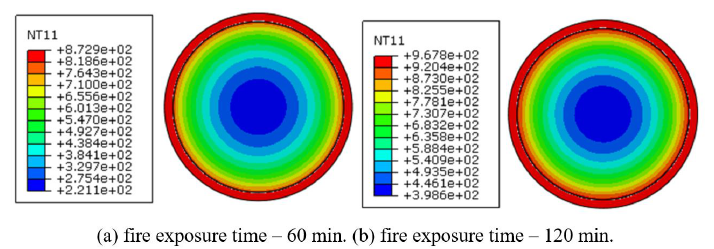
Figure 21. Temperature obtained from the numerical model with perfect thermal